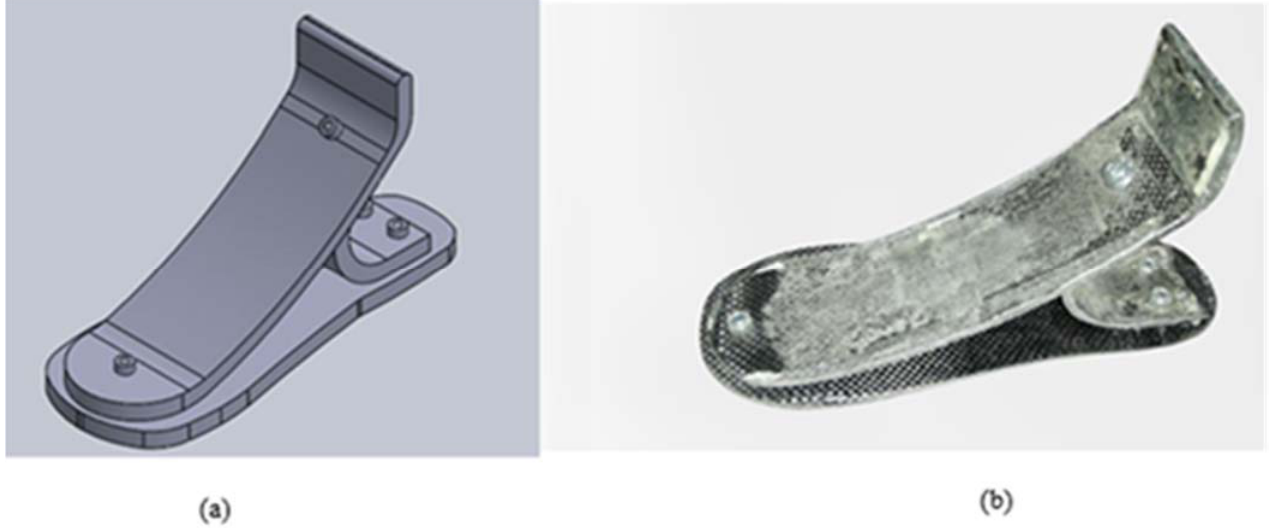
Figure 3. ( a ) CAD design for prosthetic foot prototype ( b ) Fabricated prosthetic foot prototype.